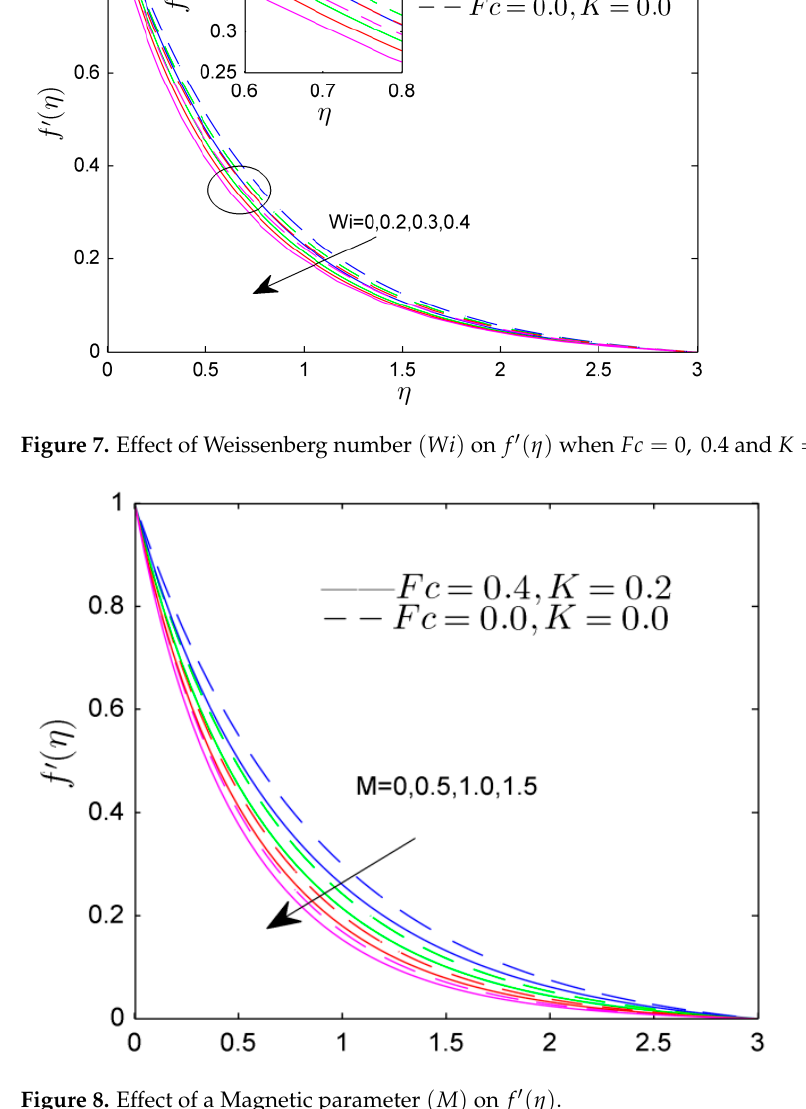
Figure 8. Effect of a Magnetic parameter (𝑀) on 𝑓 (cid:4593) ( 𝜂 ) .